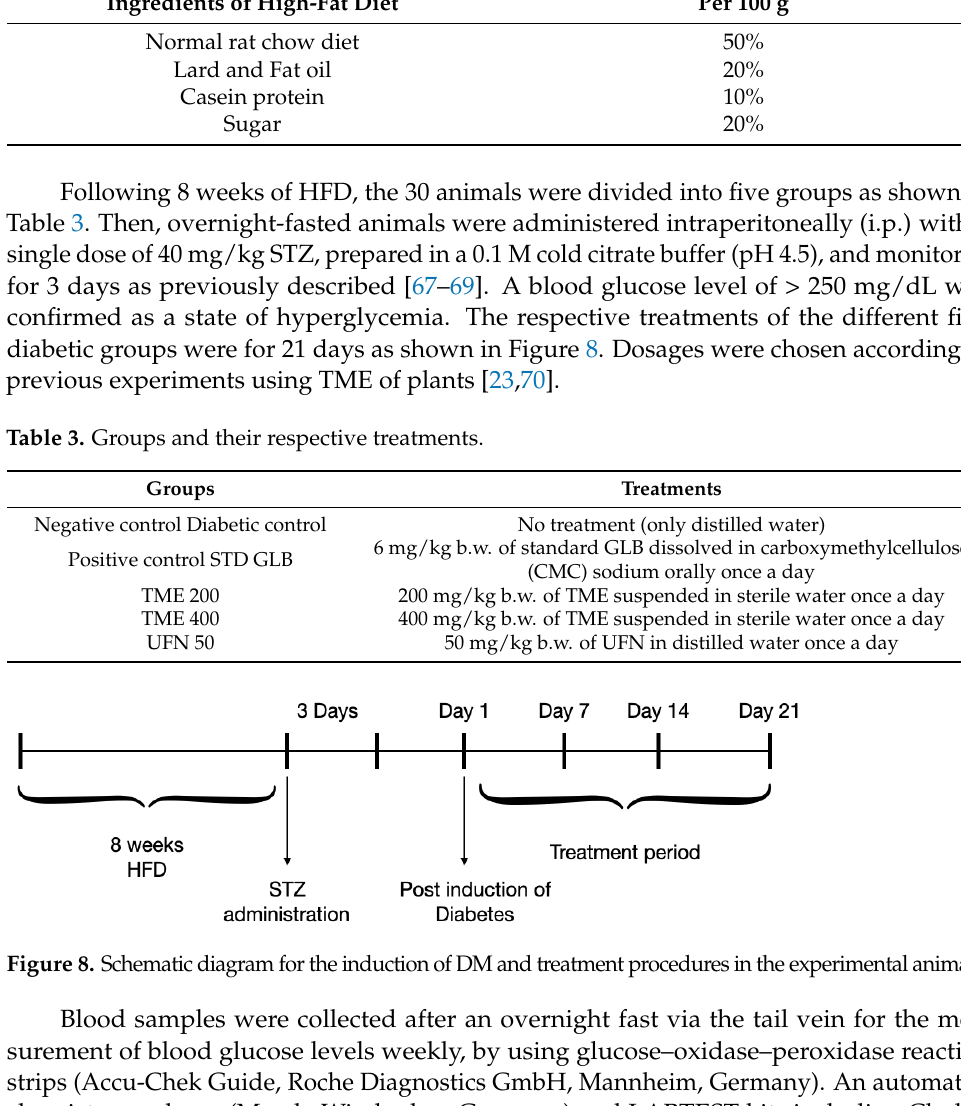
Table 2. Ingredients (%/100 g) of high-fat diet.